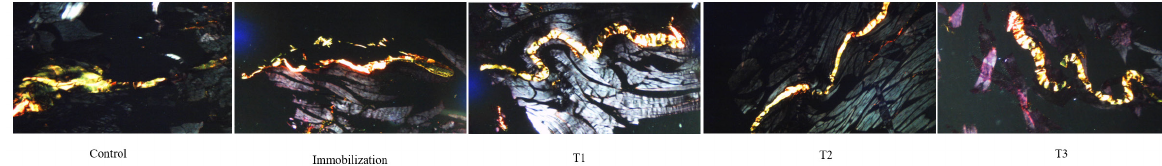
Figure 6. Histological analysis of collagen in the perimysium of the rat gastrocnemius muscle, showing variation in birificiality with green or greenish yellow (type III collagen) and orange or reddish (type I collagen) colors in the five studied groups (control, immobilized and